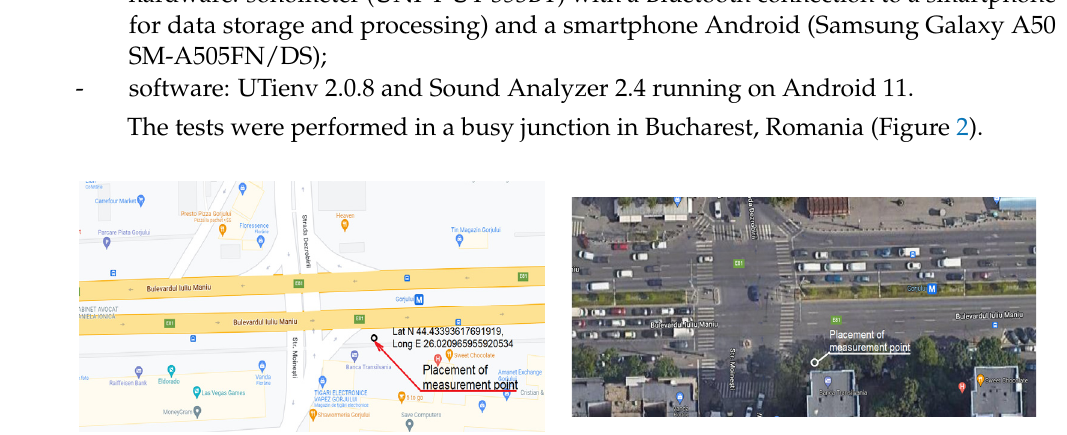
Figure 2. Placement of ground-level measurement point.